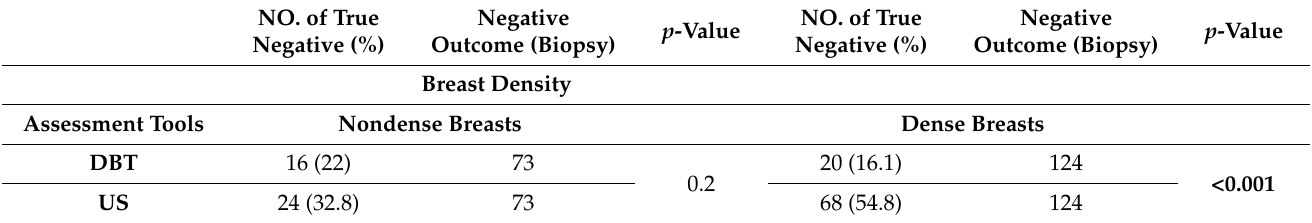
Table 3. True negative proportions of DBT and ultrasound across dense and nondense